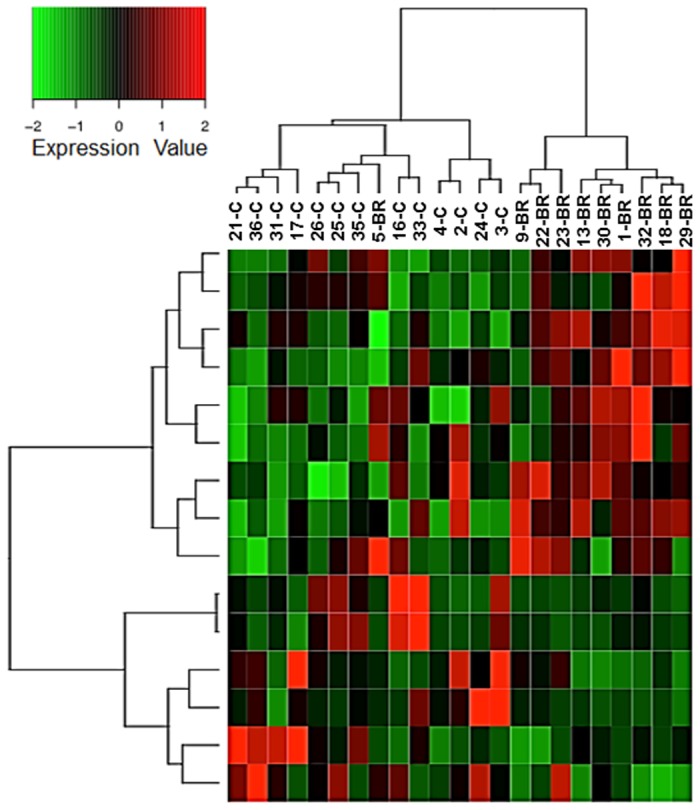
Heatmap of gene expression with hierarchical clustering for the 15 probes differentially expressed between CISHLT and BRISHLT samples.Gene expressions row scaled.